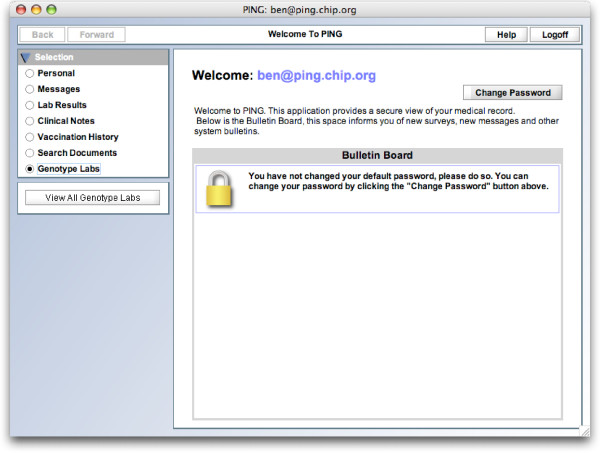
GenePING main screen. GenePING fits into the standard PING architecture. This screens shows the main PING screen with the added "Genotype Lab" option supported by the GenePING extension.